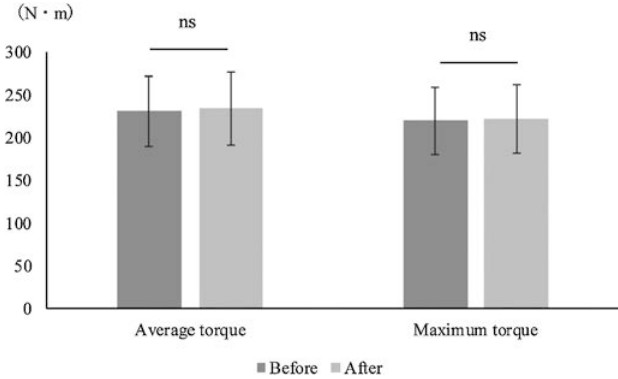
Figure 13 Bland-Altman graph showing each of the estimated maximal isometric torques before and after modification of the leg extension machine (Test 2: average angular velocity and maximum torque).